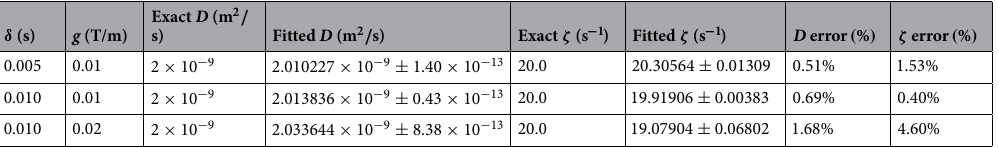
Table 1. Fit parameters of the synthetic curves obtained from BM